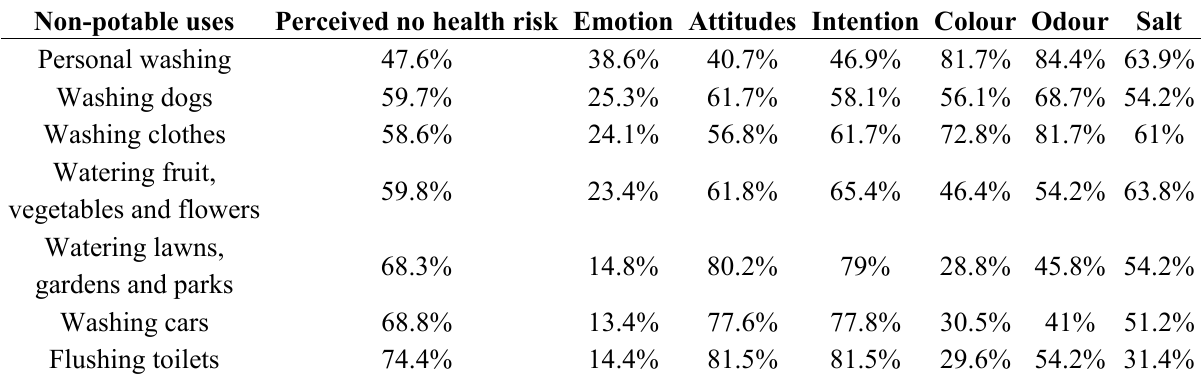
Table 3. Frequencies of influencing factors determining the uptake of stormwater for different potential uses.